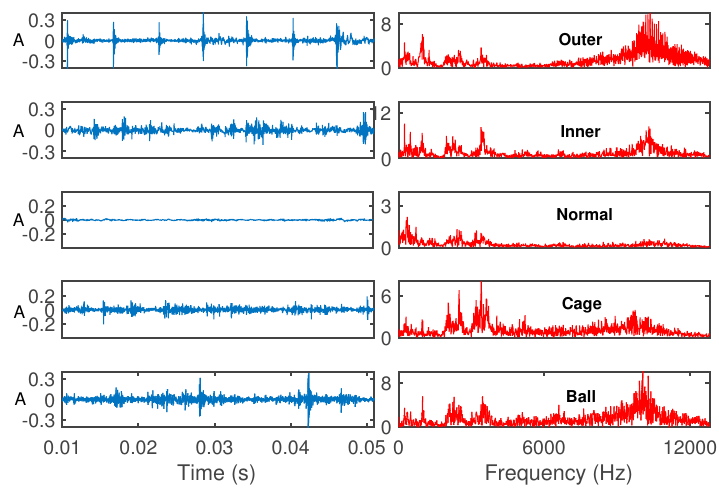
Figure 7. Original vibration signals and their spectra.